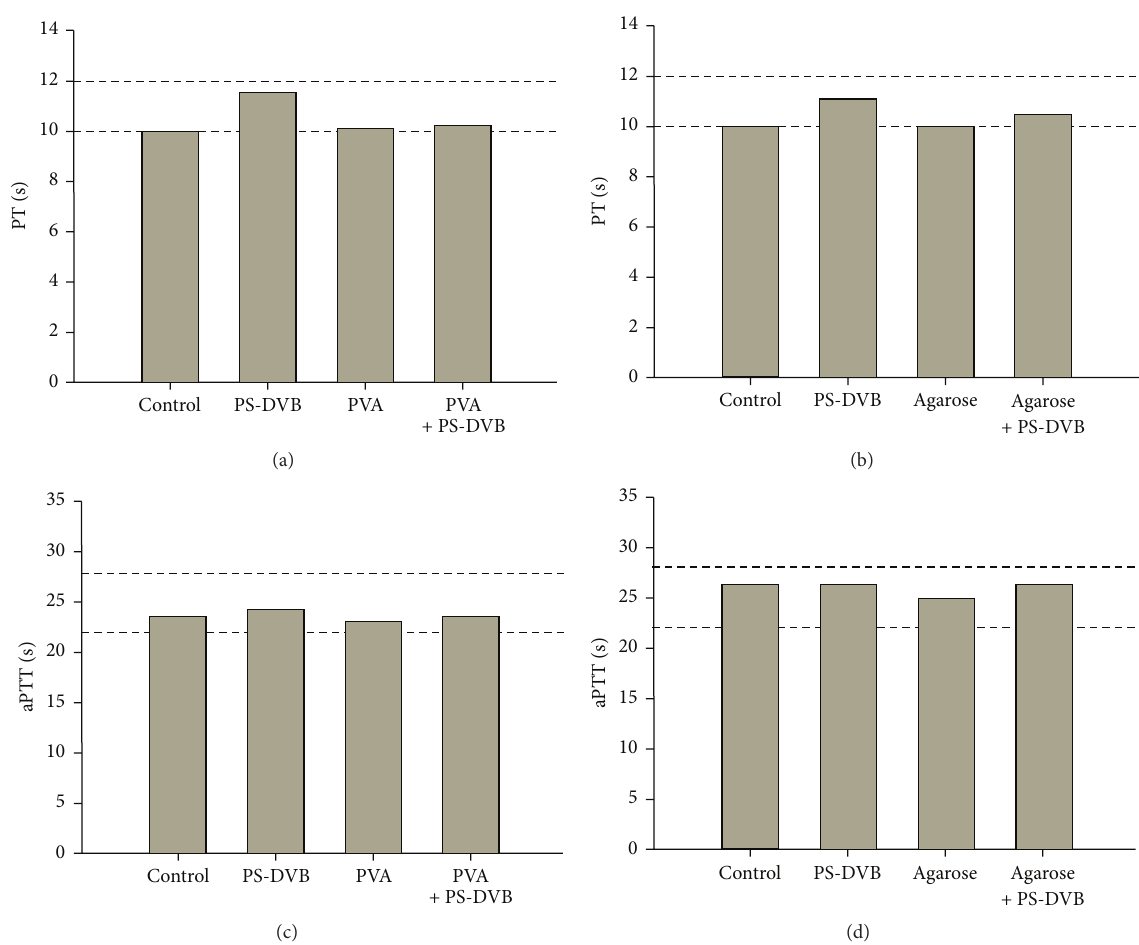
Figure 3: Prothrombin time (PT) and activated partial thromboplastin time (aPTT) for PVA- and agarose-based composite cryogels and parent PS-DVB microparticles. The horizontal lines refer to the reference range of the respective coagulation parameter.